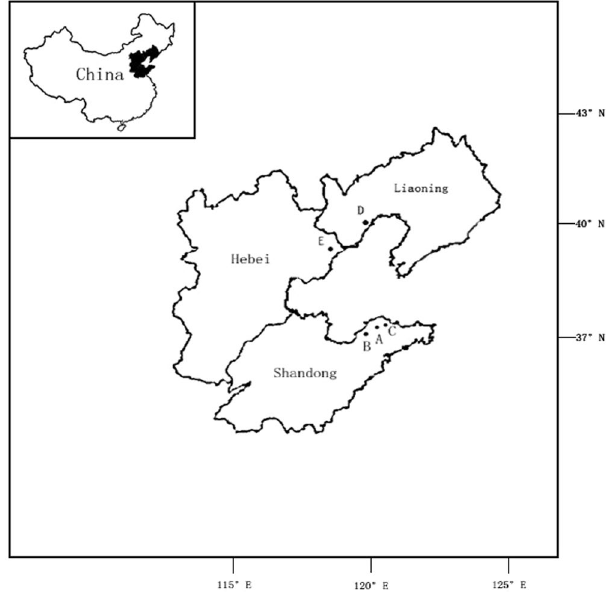
Figure 4. Location of sampling sites of soil samples around Bohai Gulf of China in five soil samples. The “A”, “B”, “C”, “D” and “E” refers to the five sampling sites: Qixia, Muping, Laizhou, Huludao and Changli, respectively. Map in this figure was generated by software Photoshop cc2015 linked with http://baoku.360.cn/soft/show/